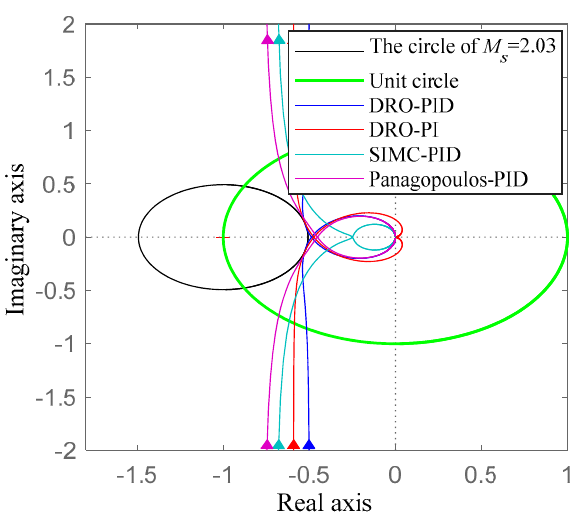
Figure 11. The Nyquist diagram for Example 2 with different controllers.